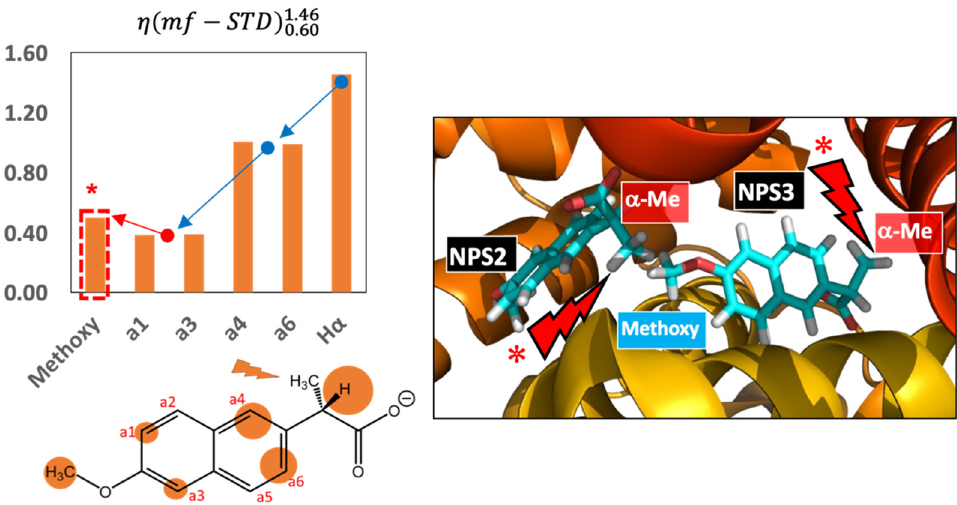
Figure 2. ( Top left ): η ( mf − STD ) 1.46 histogram for the system BSA/NPX at 500 MHz, determined 0.60 using the initial slopes of the build-up curves acquired at δ 0 = 0.60 ppm (standard STD NMR), and δ ∗ = 1.46 ppm ( on-ligand methyl group irradiation). The arrows highlight the trend along the NPX molecule (blue indicate decreases in η ( mf − STD ) 1.46 , and red increases). The η ( mf − STD ) 1.46 bar 0.60 0.60 for the methoxy protons has been boxed in a dotted square with an asterisk, to highlight the unexpected increase in η ( mf − STD ) 1.46 for the methoxy group, as this is the furthest group from the irradiated 0.60 moiety. The results report on the proximity of the two bound NPX molecules in the binding sites NPS2 and NPS3, as observed in the crystal structure of the complex (PDB ID: 4OR0, Figure S1a) [12]. In the absence of inter-ligand saturation transfer from NSP2 and NSP3, the η ( mf − STD ) 1.46 values 0.60 would monotonically decrease from the irradiated methyl group to the furthest methoxy group. ( Bottom left ): η ( mf − STD ) 1.46 values represented on the NPX chemical structure circles of sizes 0.60 proportional to the η ( mf − STD ) 1.46 values. Spectra and raw data are reported in the Supplementary 0.60 Materials, Figure S4 and Table S1. ( Right ): NPX binding sites NPS2 and NPS3 in the crystal structure of the BSA/NPX complex, PDB ID: 4OR0 [12]. In the cartoon, red rays indicate the position of the α -methyl protons directly irradiated in the STD NMR experiment ( δ ∗ = 1.46 ON